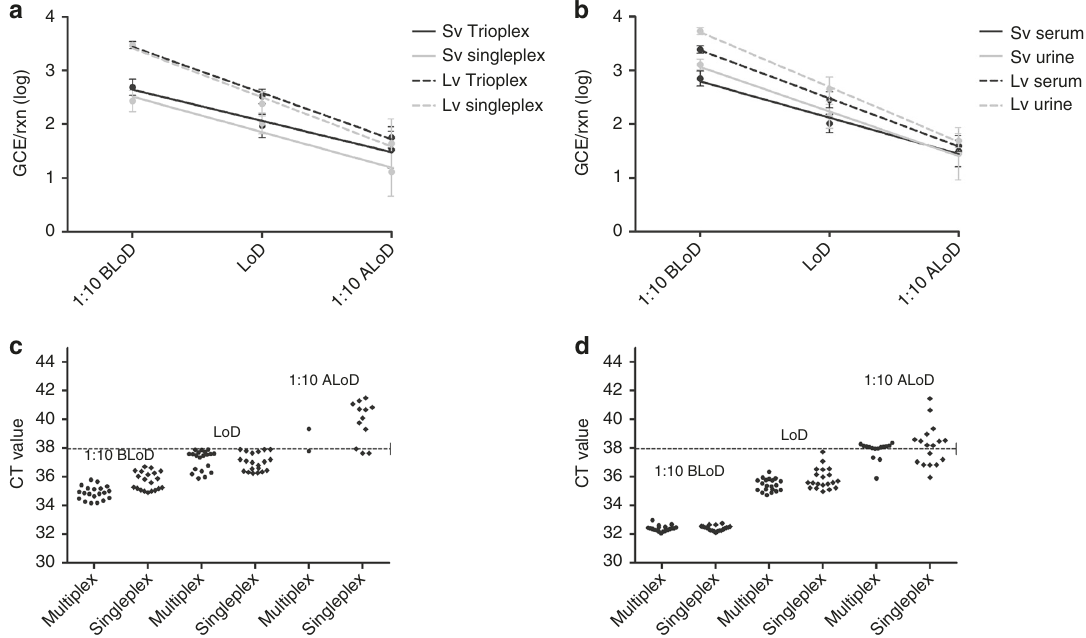
Fig. 4 Analytical performance comparison between Trioplex assay multiplex and the ZIKV singleplex format assay using small volume and large volume RNA extraction. Normal human serum or urine was contrived with ZIKV at a dilution of 1:10 before the limit of detection (1:10 BLoD), at the limit of detection (LoD), and at 1:10 after the limit of detection (1:10 ALoD). Twenty replicates of every dilution were extracted using the MagNA Pure 96 instrument (Roche) and tested by Trioplex assay multiplex or ZIKV singleplex format assay on the ABI 7500 Fast Dx or the QuantStudio Dx instruments. a Compares the mean genome copy equivalents per PCR reaction (GCE/rxn) of viral RNA extracted from serum at each dilution on the ABI 7500 Fast Dx instrument. A linear regression was plotted for multiplex with small volume protocol (Sv) (0.2 mL) (black straight line), singleplex assay with small volume protocol (gray straight line), multiplex with large volume protocol (Lv) (1 mL) (black dashed line). and singleplex assay with large volume protocol (gray dashed line). b Compares the mean genome copy equivalents per PCR reaction (GCE/rxn) of viral RNA extracted from serum or urine at each dilution on the QuantStudio Dx instrument. A linear regression was plotted for multiplex with small volume protocol serum (Sv) (black straight line), multiplex with large volume protocol serum (Lv) (gray straight line), multiplex with small volume protocol urine (Lv) (black dashed line), and multiplex with large volume protocol urine (gray dashed line). Error bars represent GCE/mL standard deviation. The CT values for every dilution replicate in serum tested was plotted